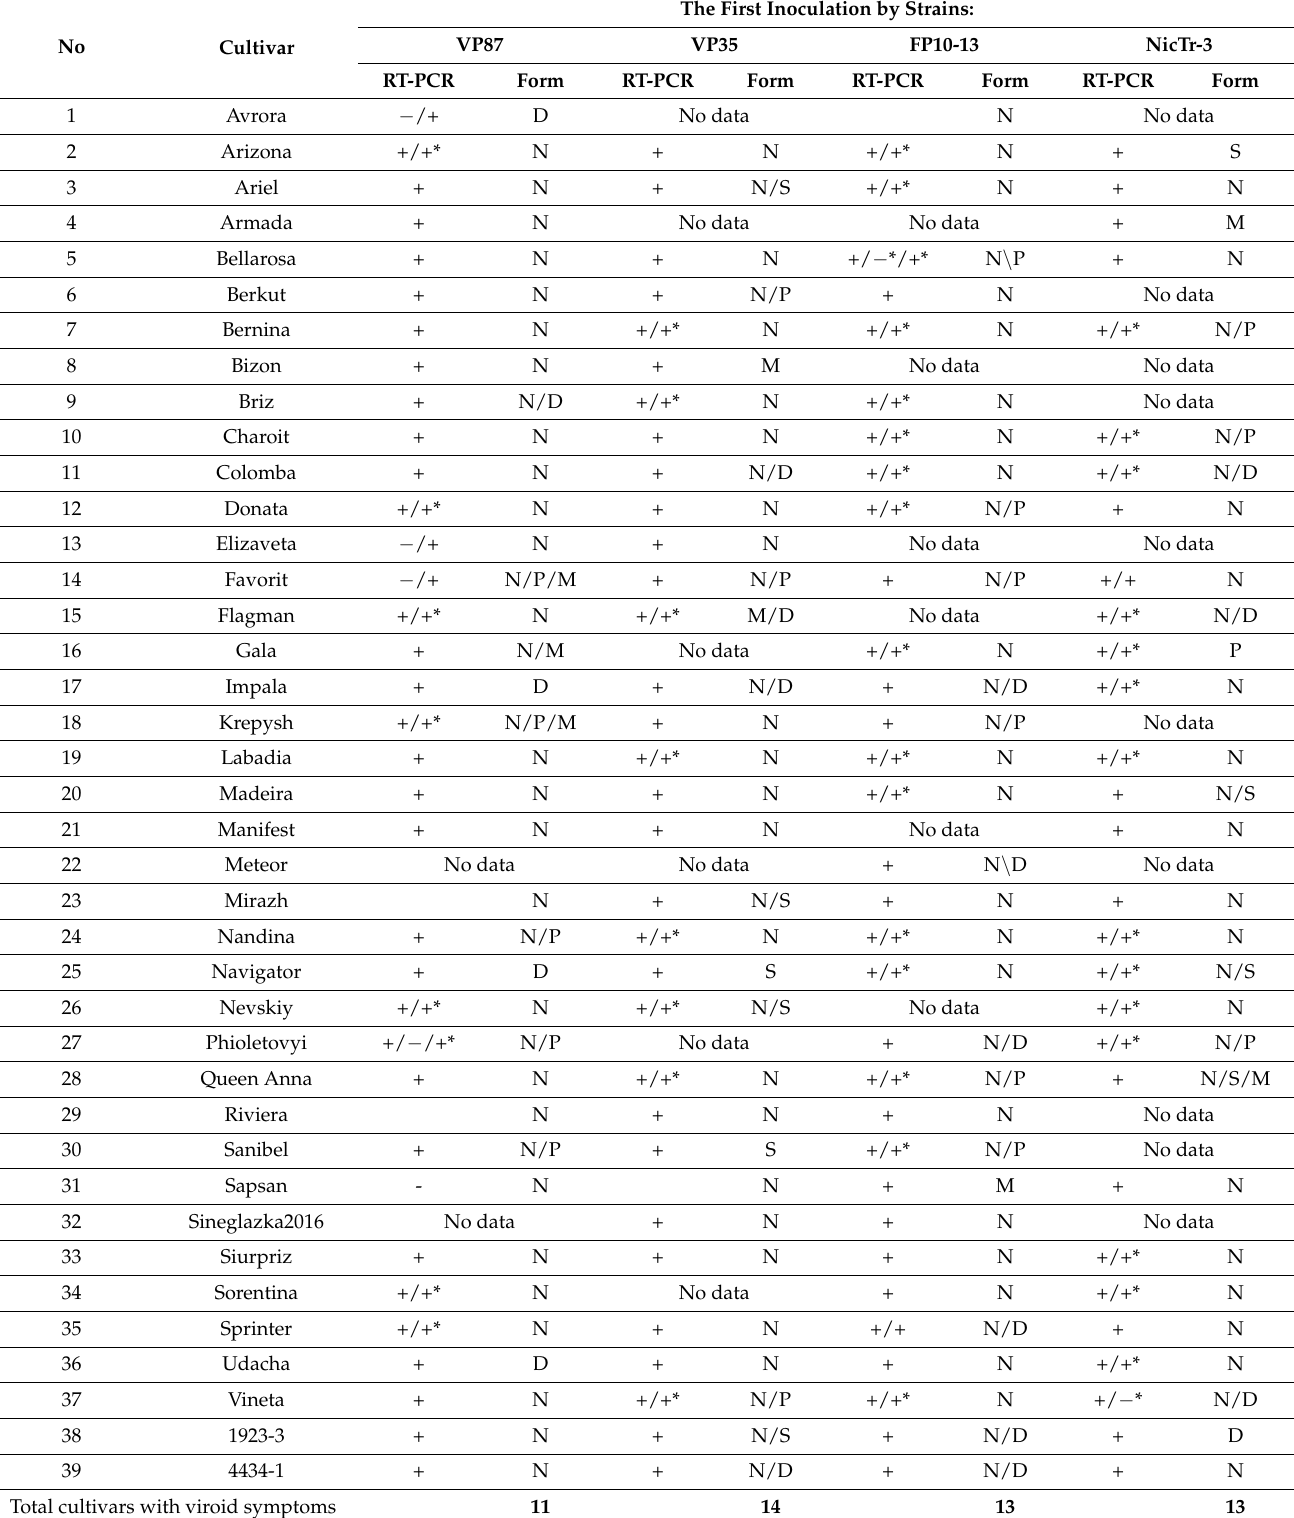
Table 1. Symptoms in potato tubers at 90 dpi with four PSTVd strains and results of viroid RT-PCR and RT-qPCR